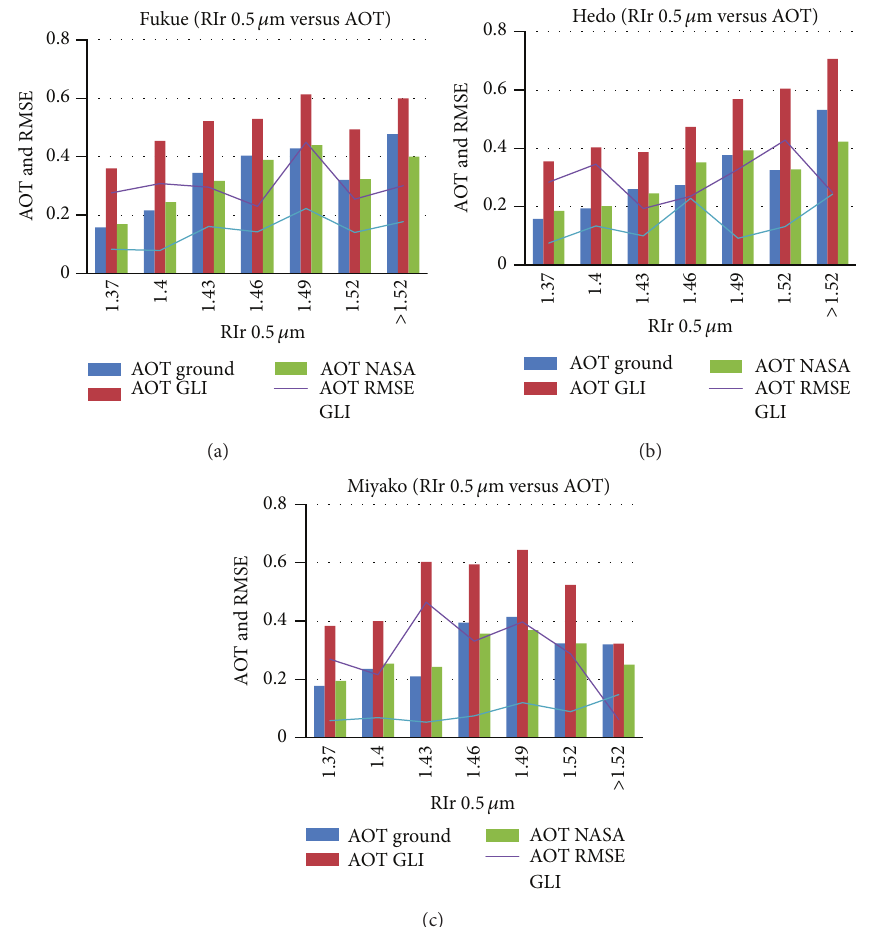
Figure 8: Real part of the refractive index (RIr) variation at the ground against ground AOT, and the satellite retrieved AOT and AOT RMSE.